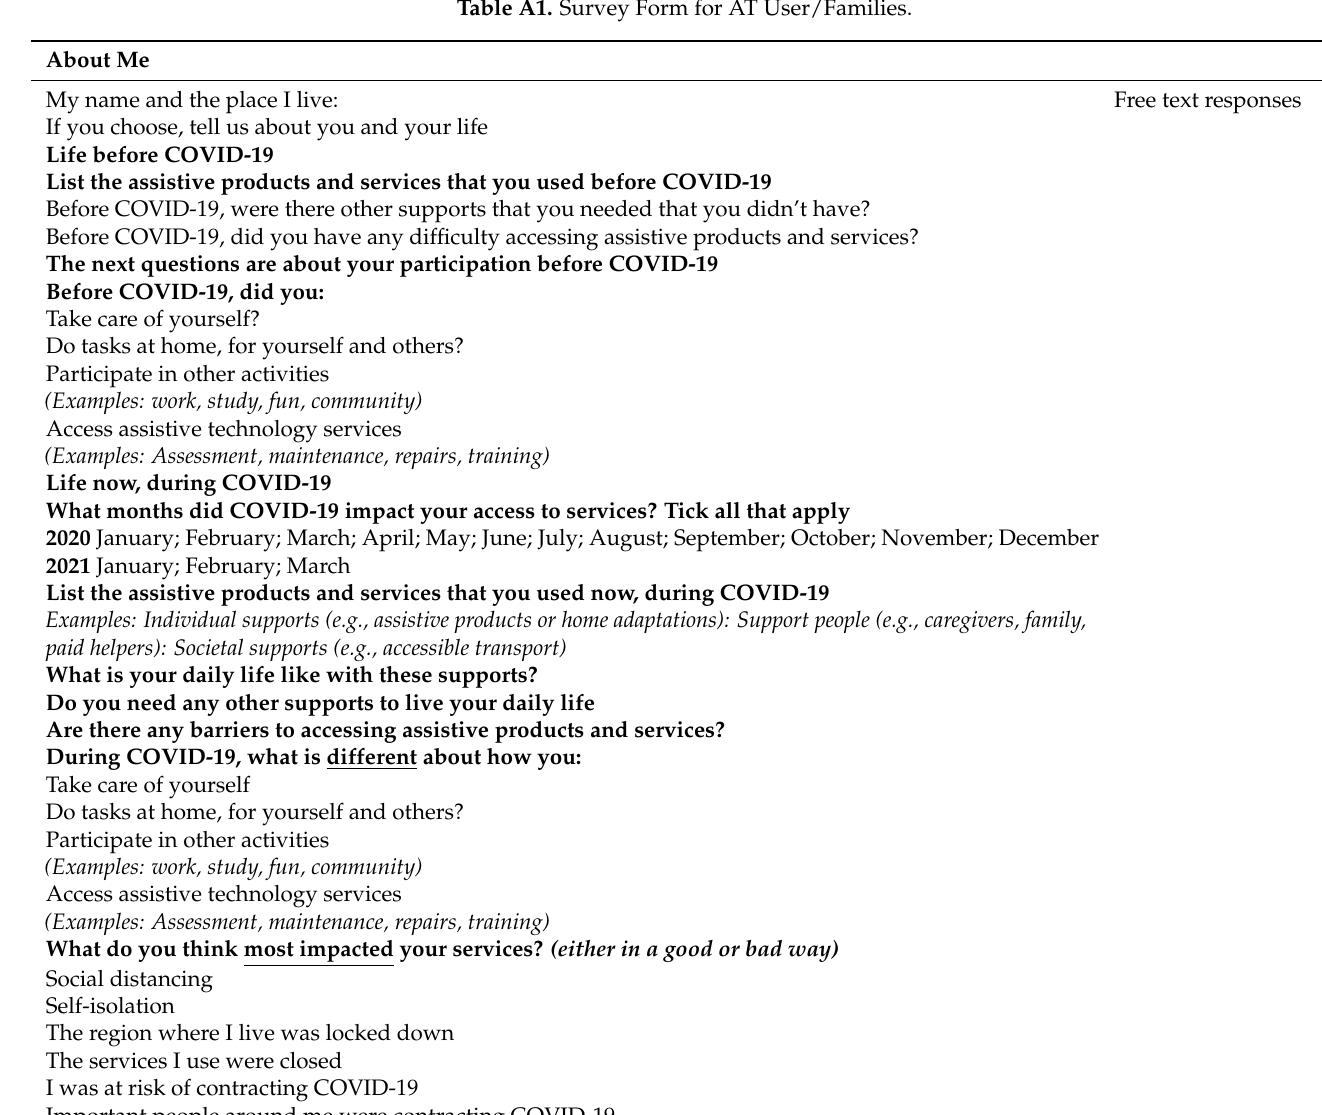
Table A1. Survey Form for AT